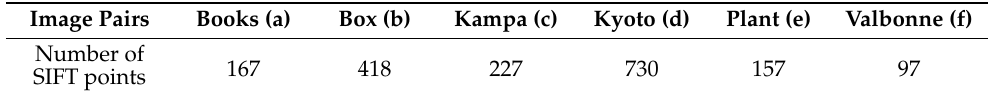
Figure 1. The image samples of the first dataset (Books ( a ), Box ( b ), Kampa ( c ), Kyoto ( d ), Plant ( e ), Valbonne ( f )). Table 1. The number of match points of the first dataset image pairs.